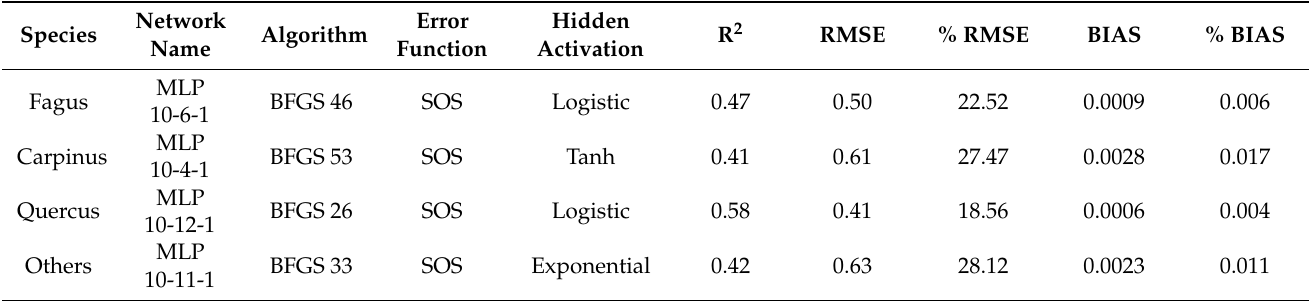
Table 6. The most important characteristics of MLP-based ANNs and associated metrics for diameter model evaluation by